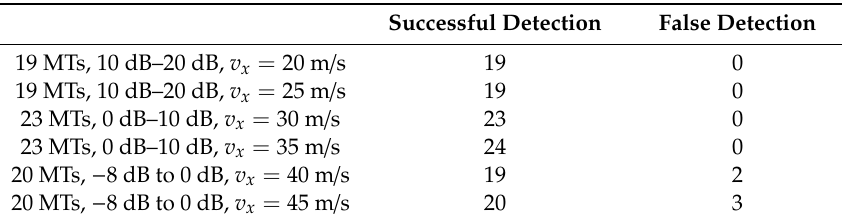
Figure 9. Sparse imaging results derived from the defocused patch in Figure 7d: ( a ) reconstructed static scene imagery, ( b ) reconstructed MT imagery after the first iteration, and ( c , d ) reconstructed MT imagery and radar data. Table 4. Detection results on the reconstructed MT